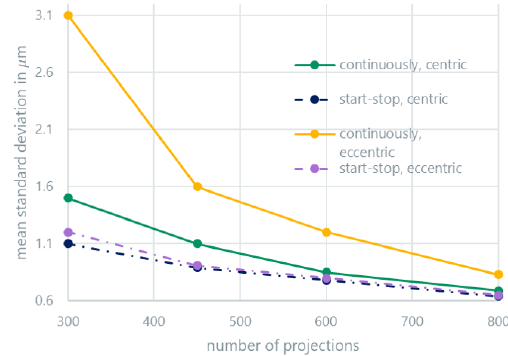
Figure 6. Random measurement error in radius measurements.